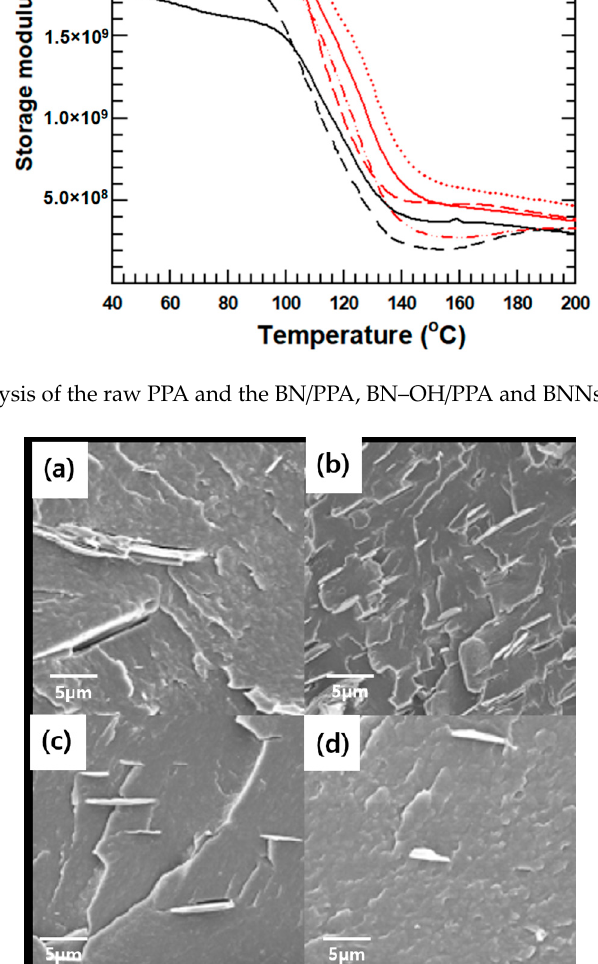
Figure 8. DMA analysis of the raw PPA and the BN/PPA, BN–OH/PPA and BNNs–X/PPA composites.